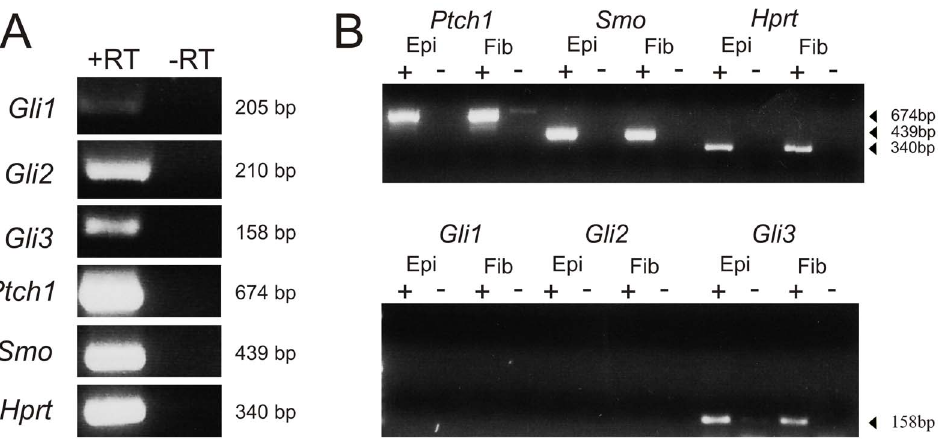
Figure 1. Expression of Hh pathway in lens. A. RT-PCR of RNA isolated from P3 lenses showing expression of Gli1, Gli2, Gli3 , Ptch1 , and Smo . Amplification of Hprt was included as a control house-keeping gene. B. RT-PCR of RNA from P10 lenses, separated into lens epithelial (Epi) and fibre (Fib) preparations, showing expression of Ptch1 , Smo and Gli3 , but not Gli1 or Gli2 . Presence ( + ) or absence ( 2 ) of reverse transcriptase in the reactions is indicated above each lane and size of each amplicon to the right of each gel.